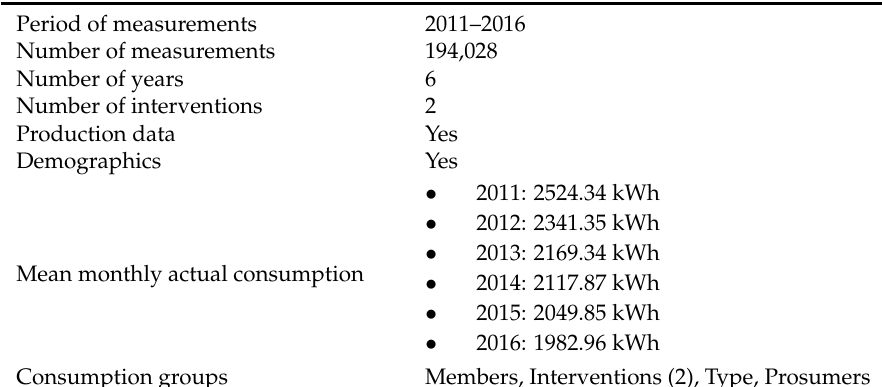
Table 6. Highlights of Ecopower’s